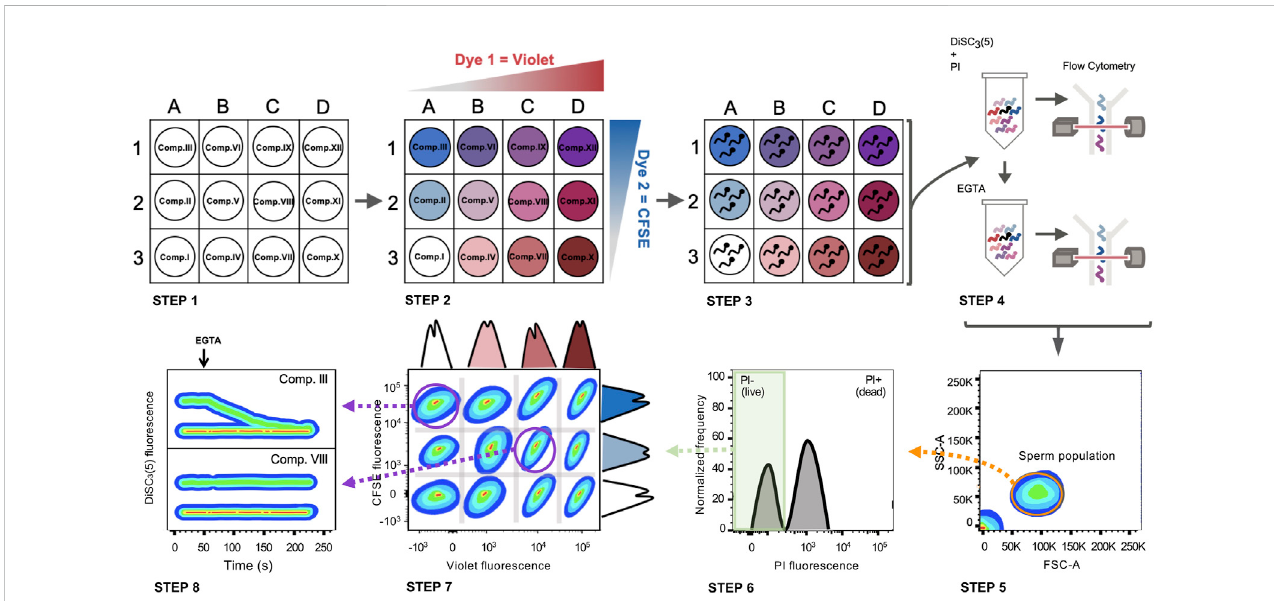
FIGURE 4 FCB in combination with Em analysis by fl ow cytometry in mouse sperm. Schematic diagram: STEP 1) A 96 well plate is prepared with a different compound in each well. STEP 2) Each well is loaded with a unique combination of dyes(CellTrace ™ Violet and CellTrace ™ CFSE). STEP 3) Sperm samples are distributed in different wells and incubated with the compounds while loading with a distinct combination of dyes. STEP 4) After loading, all samples are groupedinasingletube,loadedwithDiSC 3 (5)(Emindicator)andPI(viabilitymarker)andanalyzedby fl owcytometry(basalrecordingof30 s).Afterbasal Emacquisition,EGTA3.5 mMisaddedandimmediatelyanalyzedby fl owcytometryagain(for150 s).STEP5)Followingdataacquisition,thespermpopulation is selected from all the events recorded. STEP 6) The live sperm population is selected by gating PI-negative sperm. STEP 7) Live sperm samples can be distinguished through their corresponding dye fl uorescence signature. STEP 8) DiSC 3 (5) fl uorescence before and after EGTA addition is determined in each population, discriminating if there is any compound that promotes CatSper closure. Comp. III = does not inhibit CatSper. Comp. VIII = CatSper